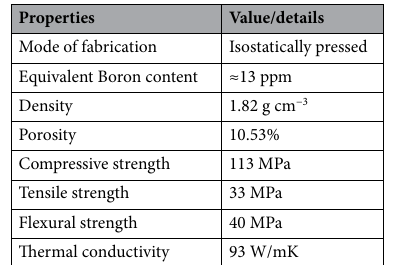
Table 1. Properties of graphite